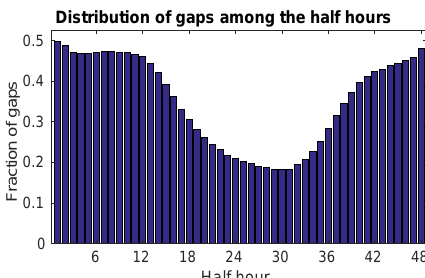
Figure B1. The distribution of gaps in the flux data of 129456 site days that we have used from 222 FLUXNET towers clearly shows a nighttime dominance of the gaps. In total, there are roughly 35% of gaps in this half-hourly flux